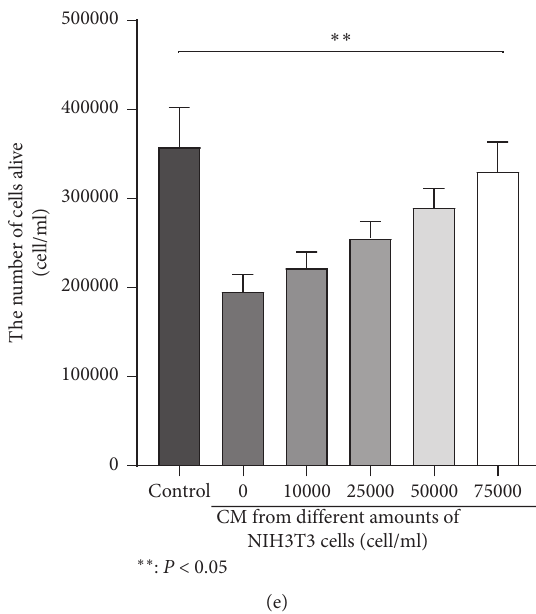
Figure 4: The concentration of 5-FU was measured in medium and in cells. (a) The concentration of 5-FU in the medium of 3T3 cells treated with 5-FU. (b) The concentrations of 5-FU in MC38 medium after a 24-hour treating with NIH3T3 CM. (c) The concentrations of 5-FU in NIH3T3 were determined after treatment with 5-FU. (d) The concentrations of 5-FU in MC38was determined 24 h after the treatment with NIH3T3 CM. (e) NIH3T3 increased the resistance of MC38 to